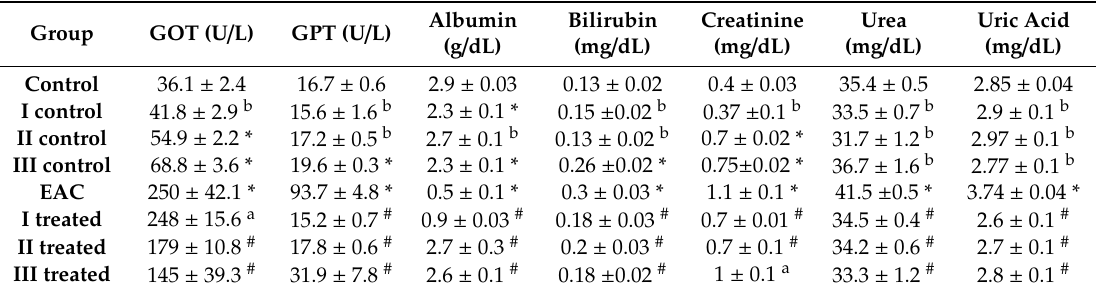
Table 4. Mean serum levels of liver and kidney function tests. Compound ( 2 ) dose concentrations: I = 6 mg / kg, II = 12 mg / kg, and III = 18 mg /